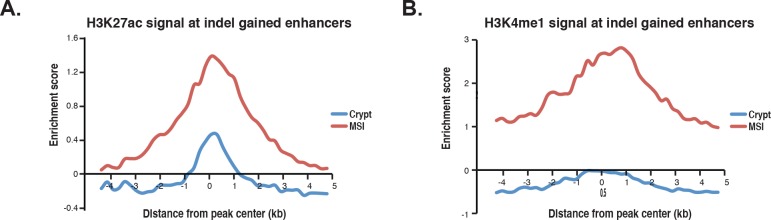
Enhancer histone profiles at indel gained enhancers.(A) Aggregate plot of H3K27ac signal in MSI lines harboring putative enhancer-activating indels and in normal crypt cells. (B) Same, but plotting the H3K4me1 signal.